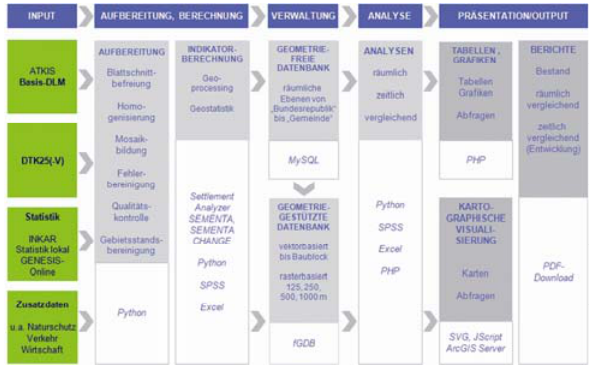
Figure 1. Workflow of the Monitor of settlement and